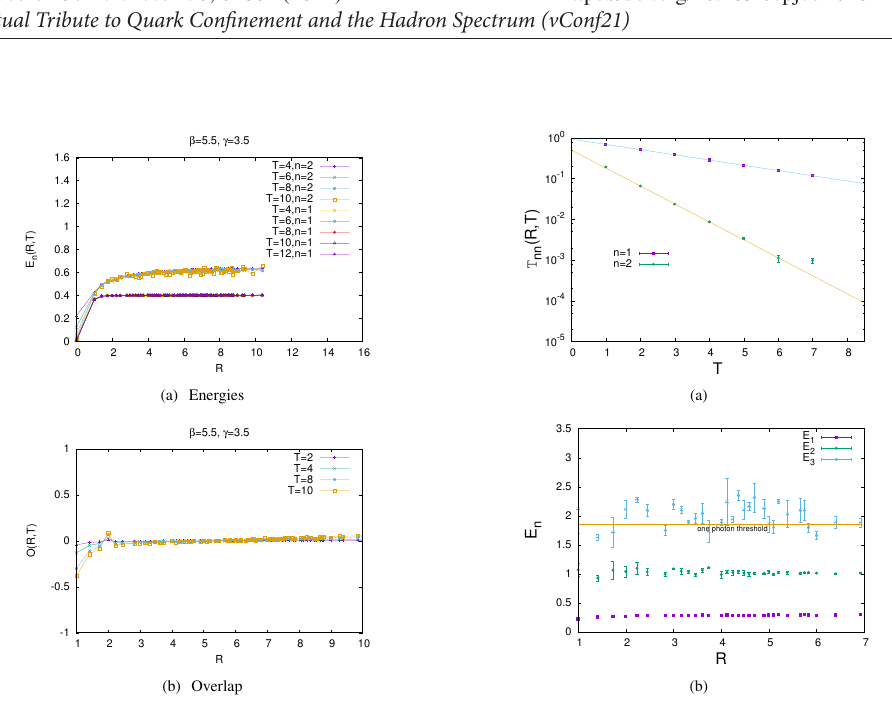
Figure 1. (a) Energies E n ( R , T ) of states 1 , 2 after evolution Figure2. (a)Anexampleoffitsat R = 6 . 93ona16 4 latticeinthe for a period of ( T 1) / 2 units of Euclidean time, at lattice cou- abelian Higgs model, with couplings β = 3 ,γ = 0 . 5. (b) Low- − plings β = 5 . 5 ,γ = 3 . 5. Note the energy gap, which persists out est, first excited, and second excited state energies vs. fermion E 1 ( R , T ) to the largest T values shown, of E 2 ( R , T ) 0 . 2 in − ⇡ lattice units. (b) The overlap ( R , T ) between states 1 ( R ) and O 2 ( R ) which are evolved (and then normalized) for T / 2 units of Euclidean time. ( R , T ) = 0 by construction at T = 0 , 1, but the O Euclidean time-evolved states are seen to remain approximately orthogonal for R > 2 at larger T .